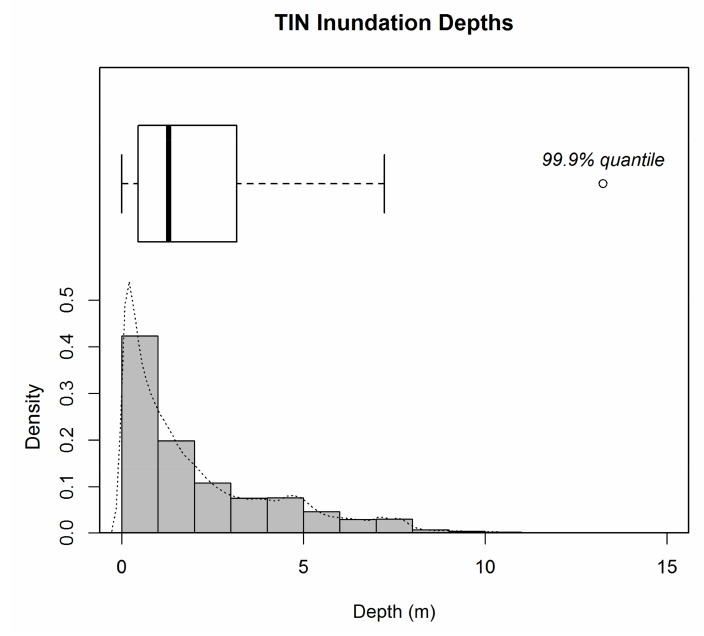
Figure A3. Full distribution of inundation depths produced by TIN